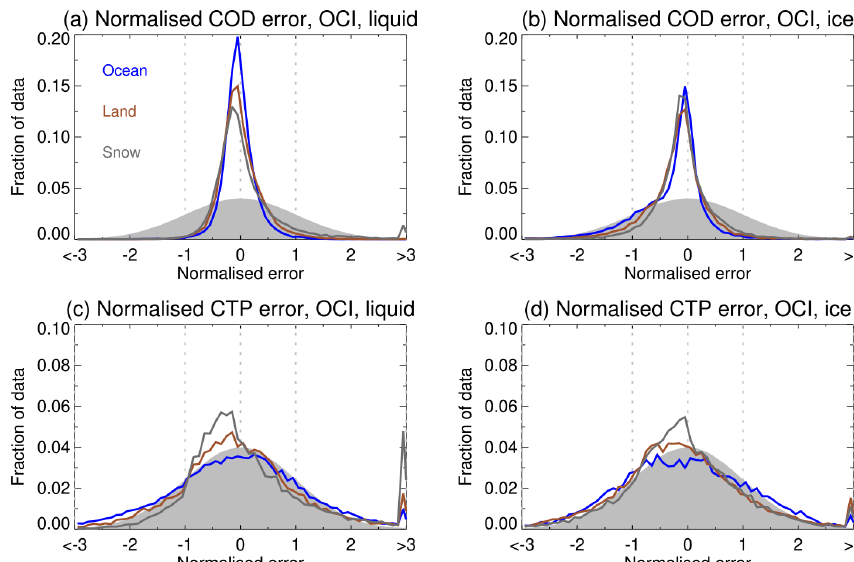
Figure 15. Histograms of normalised retrieval error for OCI for the case where cloud phase is known beforehand. Blue, brown, and grey indicate ocean-like, land-like, and snow-like simulations. Panels (a) and (b) show COT and (c) and (d) CTP. Panels (a) and (c) show results for liquid-phase simulations and (b) and (d) for ice-phase simulations. Grey shading shows the theoretical Gaussian distribution which would be observed if uncertainty estimates were calibrated perfectly. Vertical dotted lines indicate normalised errors of − 1, 0, and + 1.